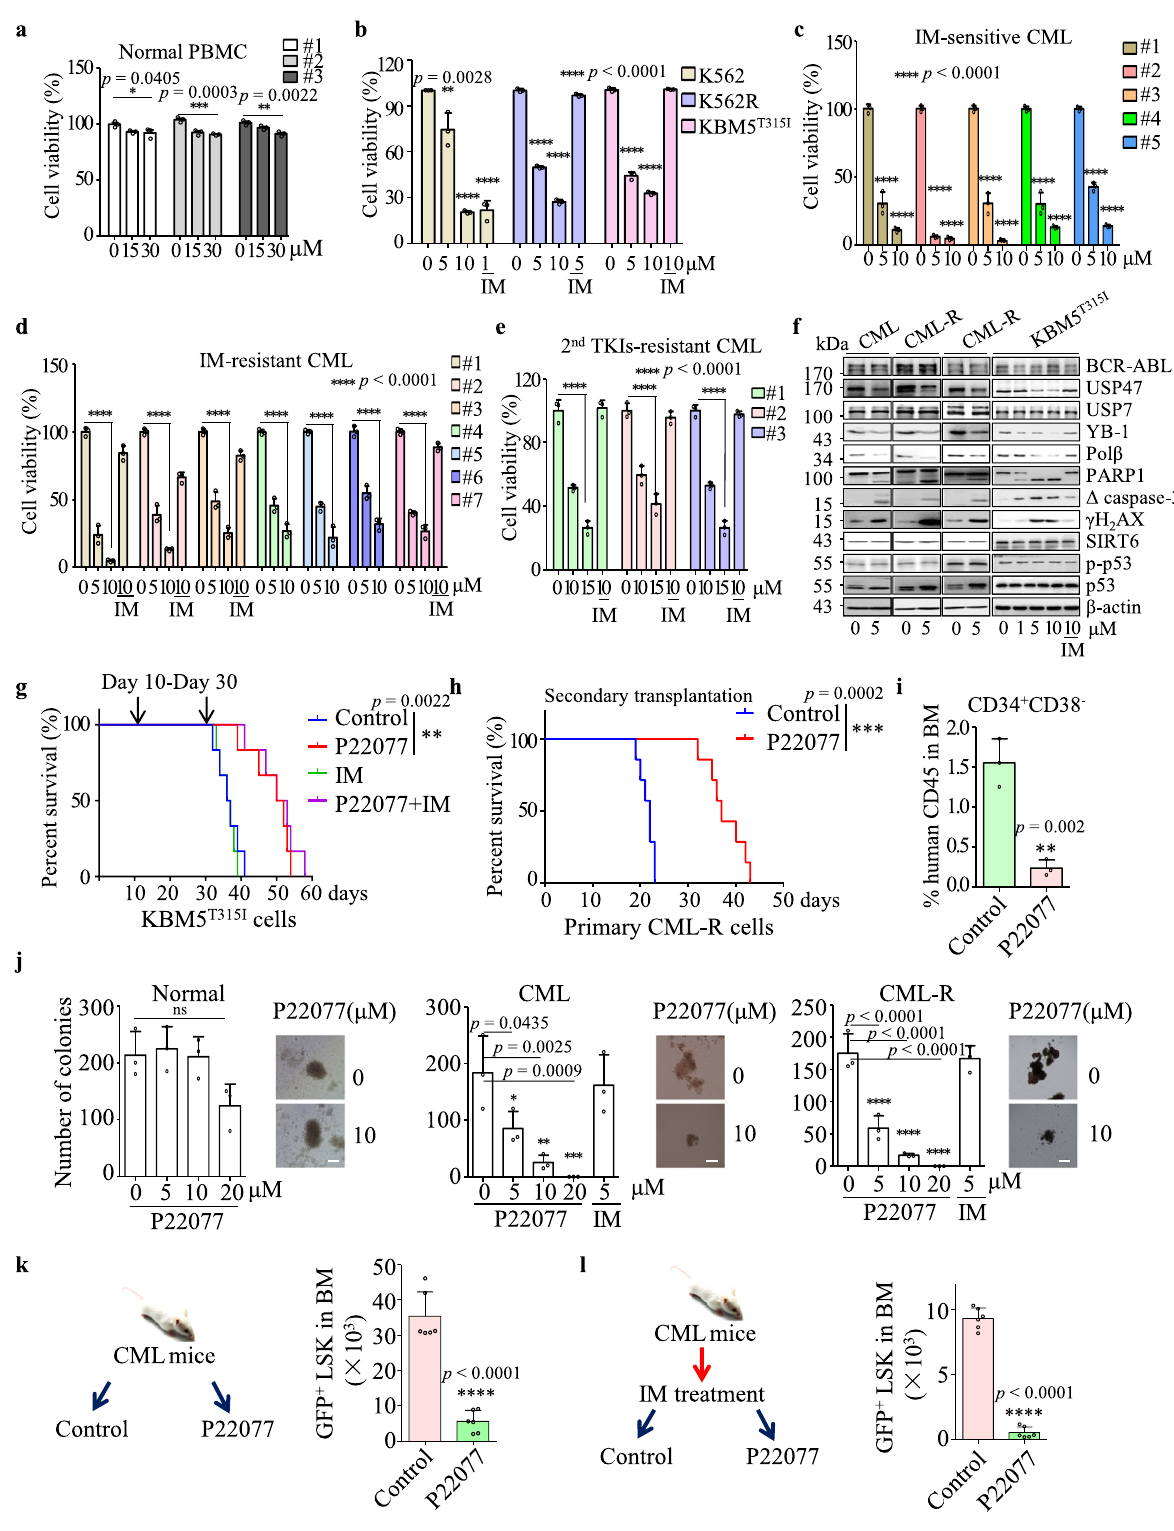
DNA damage quanti fi cation . Genomic DNA was isolated and puri fi ed using the QIAamp DNA Mini Kit (51304; QIAGEN, Hilden, Germany). The number of apurinic/apyrimidinic sites (AP sites) was determined using the DNA Damage Quanti fi cation Kit (DK02, DOJINDO Laboratories, Kumamoto, Japan) according to the manufacturer ’ s instruction. Cell viability assay . CML cell lines and primary CML cells were incubated with different concentrations of P22077 and/or IM for 48h. Cell viability was assayed NATURE COMMUNICATIONS| (2021) 12:51 |https://doi.org/10.1038/s41467-020-20259-0|www.nature.com/naturecommunications